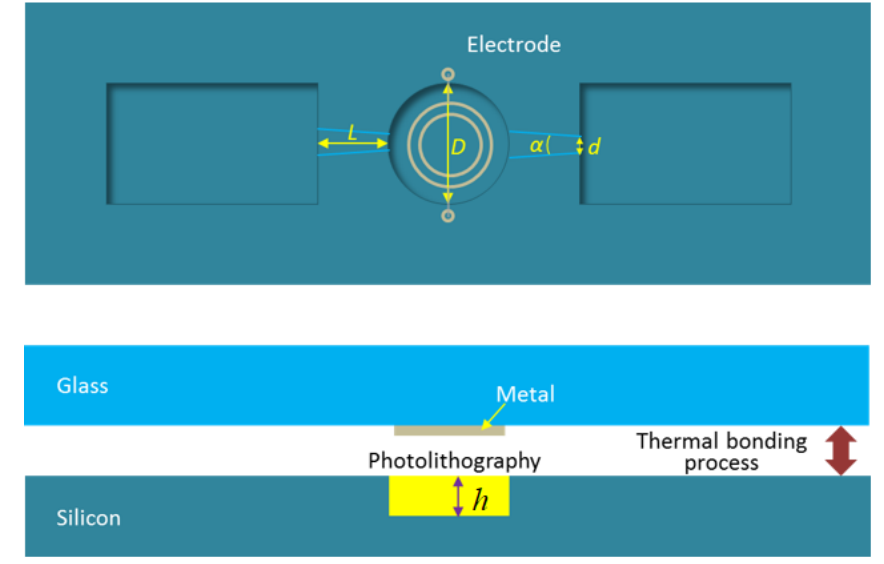
Figure 4. Fabrication process of the micro heater. ( D and h are the diameter and the depth, respectively, of the pump chamber; L indicates the length of inlet/outlet ports; d is the diameter of the small end and α is the convergence angle of the inlet/outlet ports).